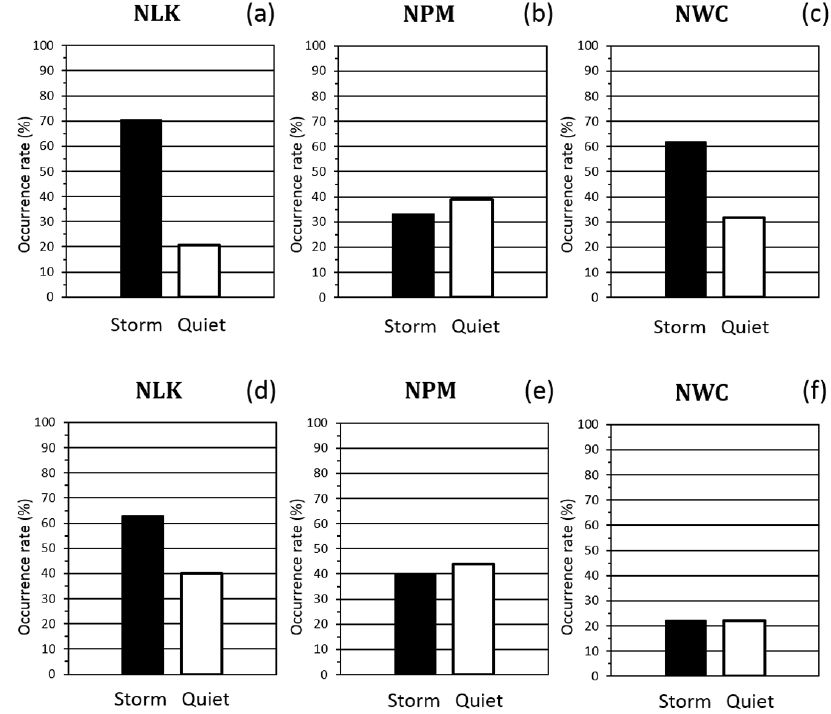
Figure 5. Histograms summarizing the statistical results for the case B with the same format as the case A in Fig.